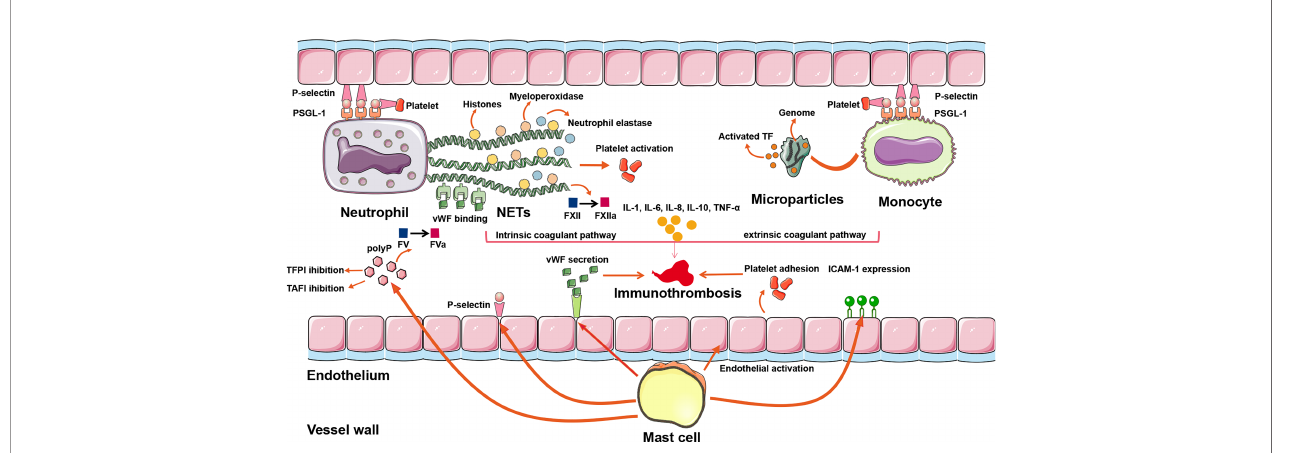
FIGURE 2 | The in fl ammatory mechanisms of CVT formation. A plethora of in fl ammatory pathways are implicated in CVST formation: (1) NETs extruded by neutrophils can directly activate FXII, bind to vWF, trigger platelet recruitment, and concentrate enzymes such as neutrophil elastase and myeloperoxidase, so that intrinsic coagulant pathway is activated. (2) Activated TF is delivered by microparticles within monocytes to the sites of pathogen exposure. Assisting with adherence of extruded NETs, the extrinsic coagulant pathway is triggered. (3) Mast cells exert their prothrombotic actions through the release of a granular constituent, leading to endothelial activation, platelet adhesion, vWF secretion, leukocyte recruitment, P-selection release, and ICAM-1 expression. (4) Proin fl ammatory cytokines such as IL-1, IL-6, IL-8, IL-10, and TNF- a modulate the in fl ammatory reactions to affect the evolution or resolution of thrombosis. (5) Binding of P-selectin to PSGL-1 initiates the rolling leukocytes adhering on activated platelets and endothelial cells, renders neutrophils migrating to the sites of injury, promotes NETs formation in the setting of activated platelets, and promotes monocytes releasing TF-bearing microparticles. ICAM-1, intercellular adhesion molecule-1; NETs, neutrophil extracellular traps; polyP, polyphosphate; PSGL-1, P-selectin glycoprotein ligand 1; TAFI, thrombin-activatable fi brinolysis inhibitor; TF, tissue factor; TFPI, tissue factor pathway inhibitor; vWF, von Willebrand factor; CVT, cerebral venous thrombosis; CVST, cerebral venous sinus